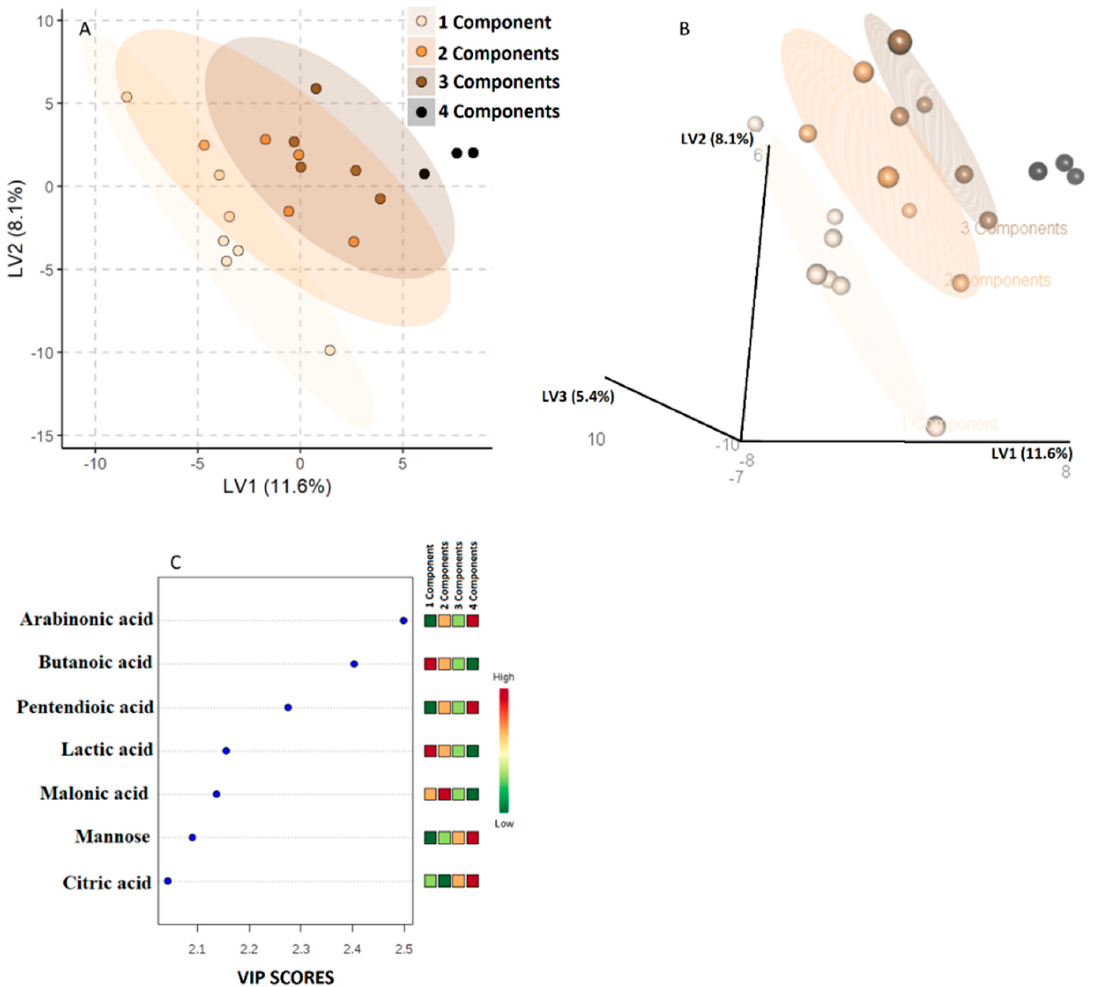
Figure 2. Partial least squares discriminant analysis (PLS-DA) model to discriminate obese children according to the number of Metabolic Syndrome (MetS) components. The explained variance of each component is shown on the corresponding axis. In panels A and B , the color darkness progression denotes the MetS components increase. The seven metabolites with a variable important in projection score (VIP-score) higher than 2 are shown in Panel C .